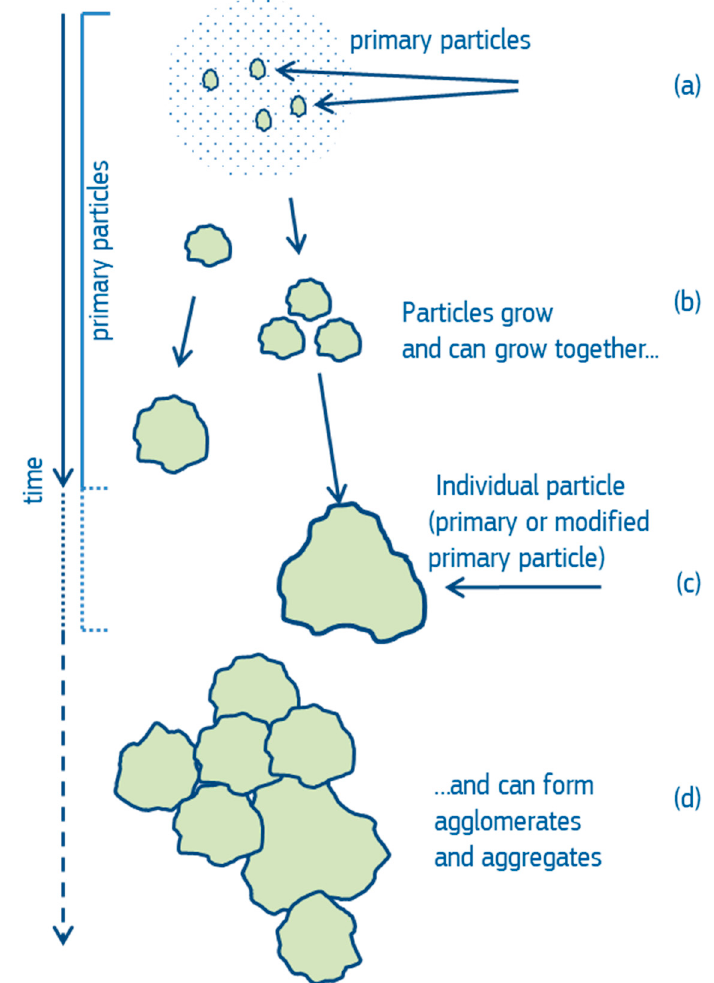
Figure 1. Illustration of particle generation via the bottom-up process.